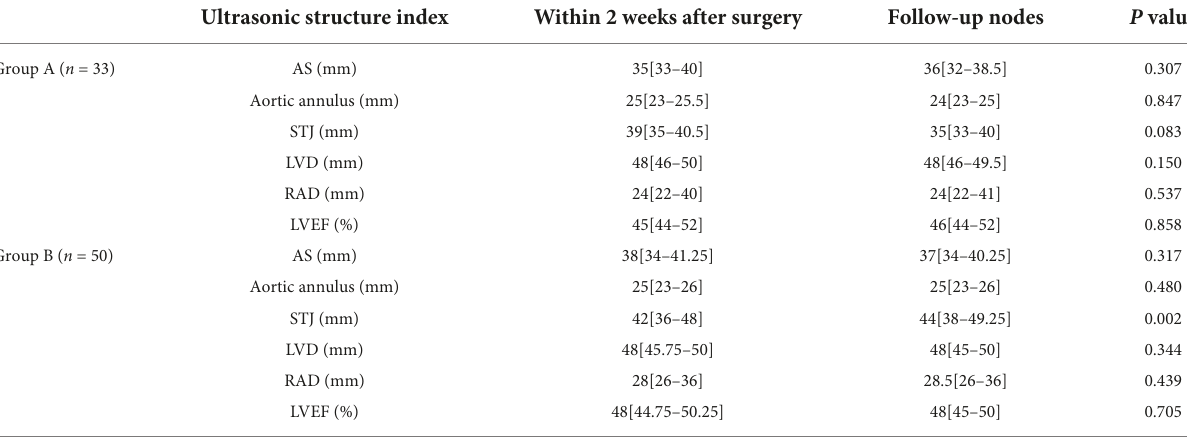
TABLE 2 Changes in cardiac structure after surgery and at follow-up